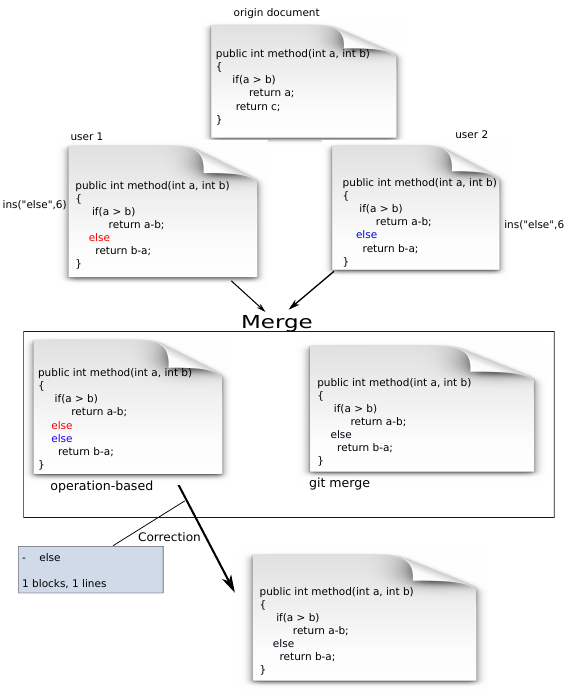
Figure 13. Accidental clean